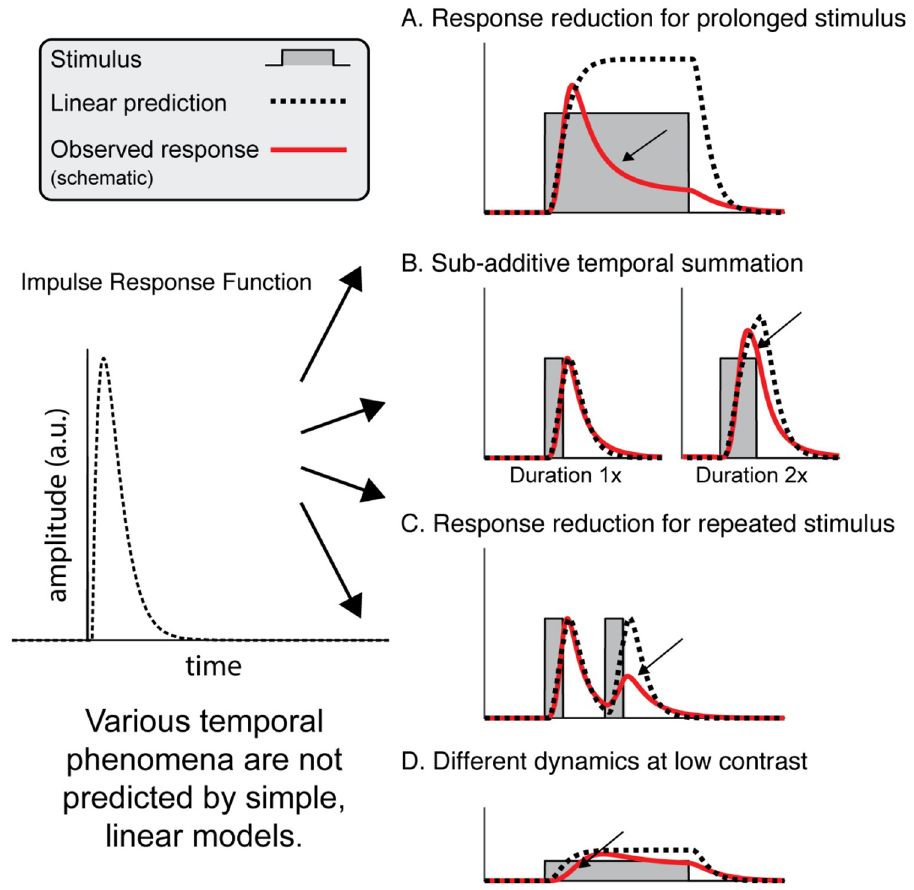
Fig 1. Schematic of different temporal phenomena observed in neural response time courses. For each phenomenon, we show a schematic with a stimulus time course (gray shading), a linear prediction (black dashed line), and a cartoon illustration of plausible neuronal responses consistent with prior findings (red line). The linear prediction is the result of convolving an impulse response (left) with a stimulus time course. A. For a sustained stimulus, the neuronal response reduces after an initial transient, differing from the sustained linear prediction [e.g., 2, 3]. B. Neuronal responses sum sub-linearly in time: doubling the stimulus duration results in a total response that is less than double (less than the linear prediction) [3, 4]. C. For two presentations of a single image with a brief gap in between, the neuronal response to the second presentation is lower than the linear prediction (e.g., refs [2, 4, 5]). D. Compared to the linear prediction, the neuronal response to a low contrast stimulus is both lower in amplitude and delayed [4, 6, 7].